Question: In a single sentence, describe what this figure presents.
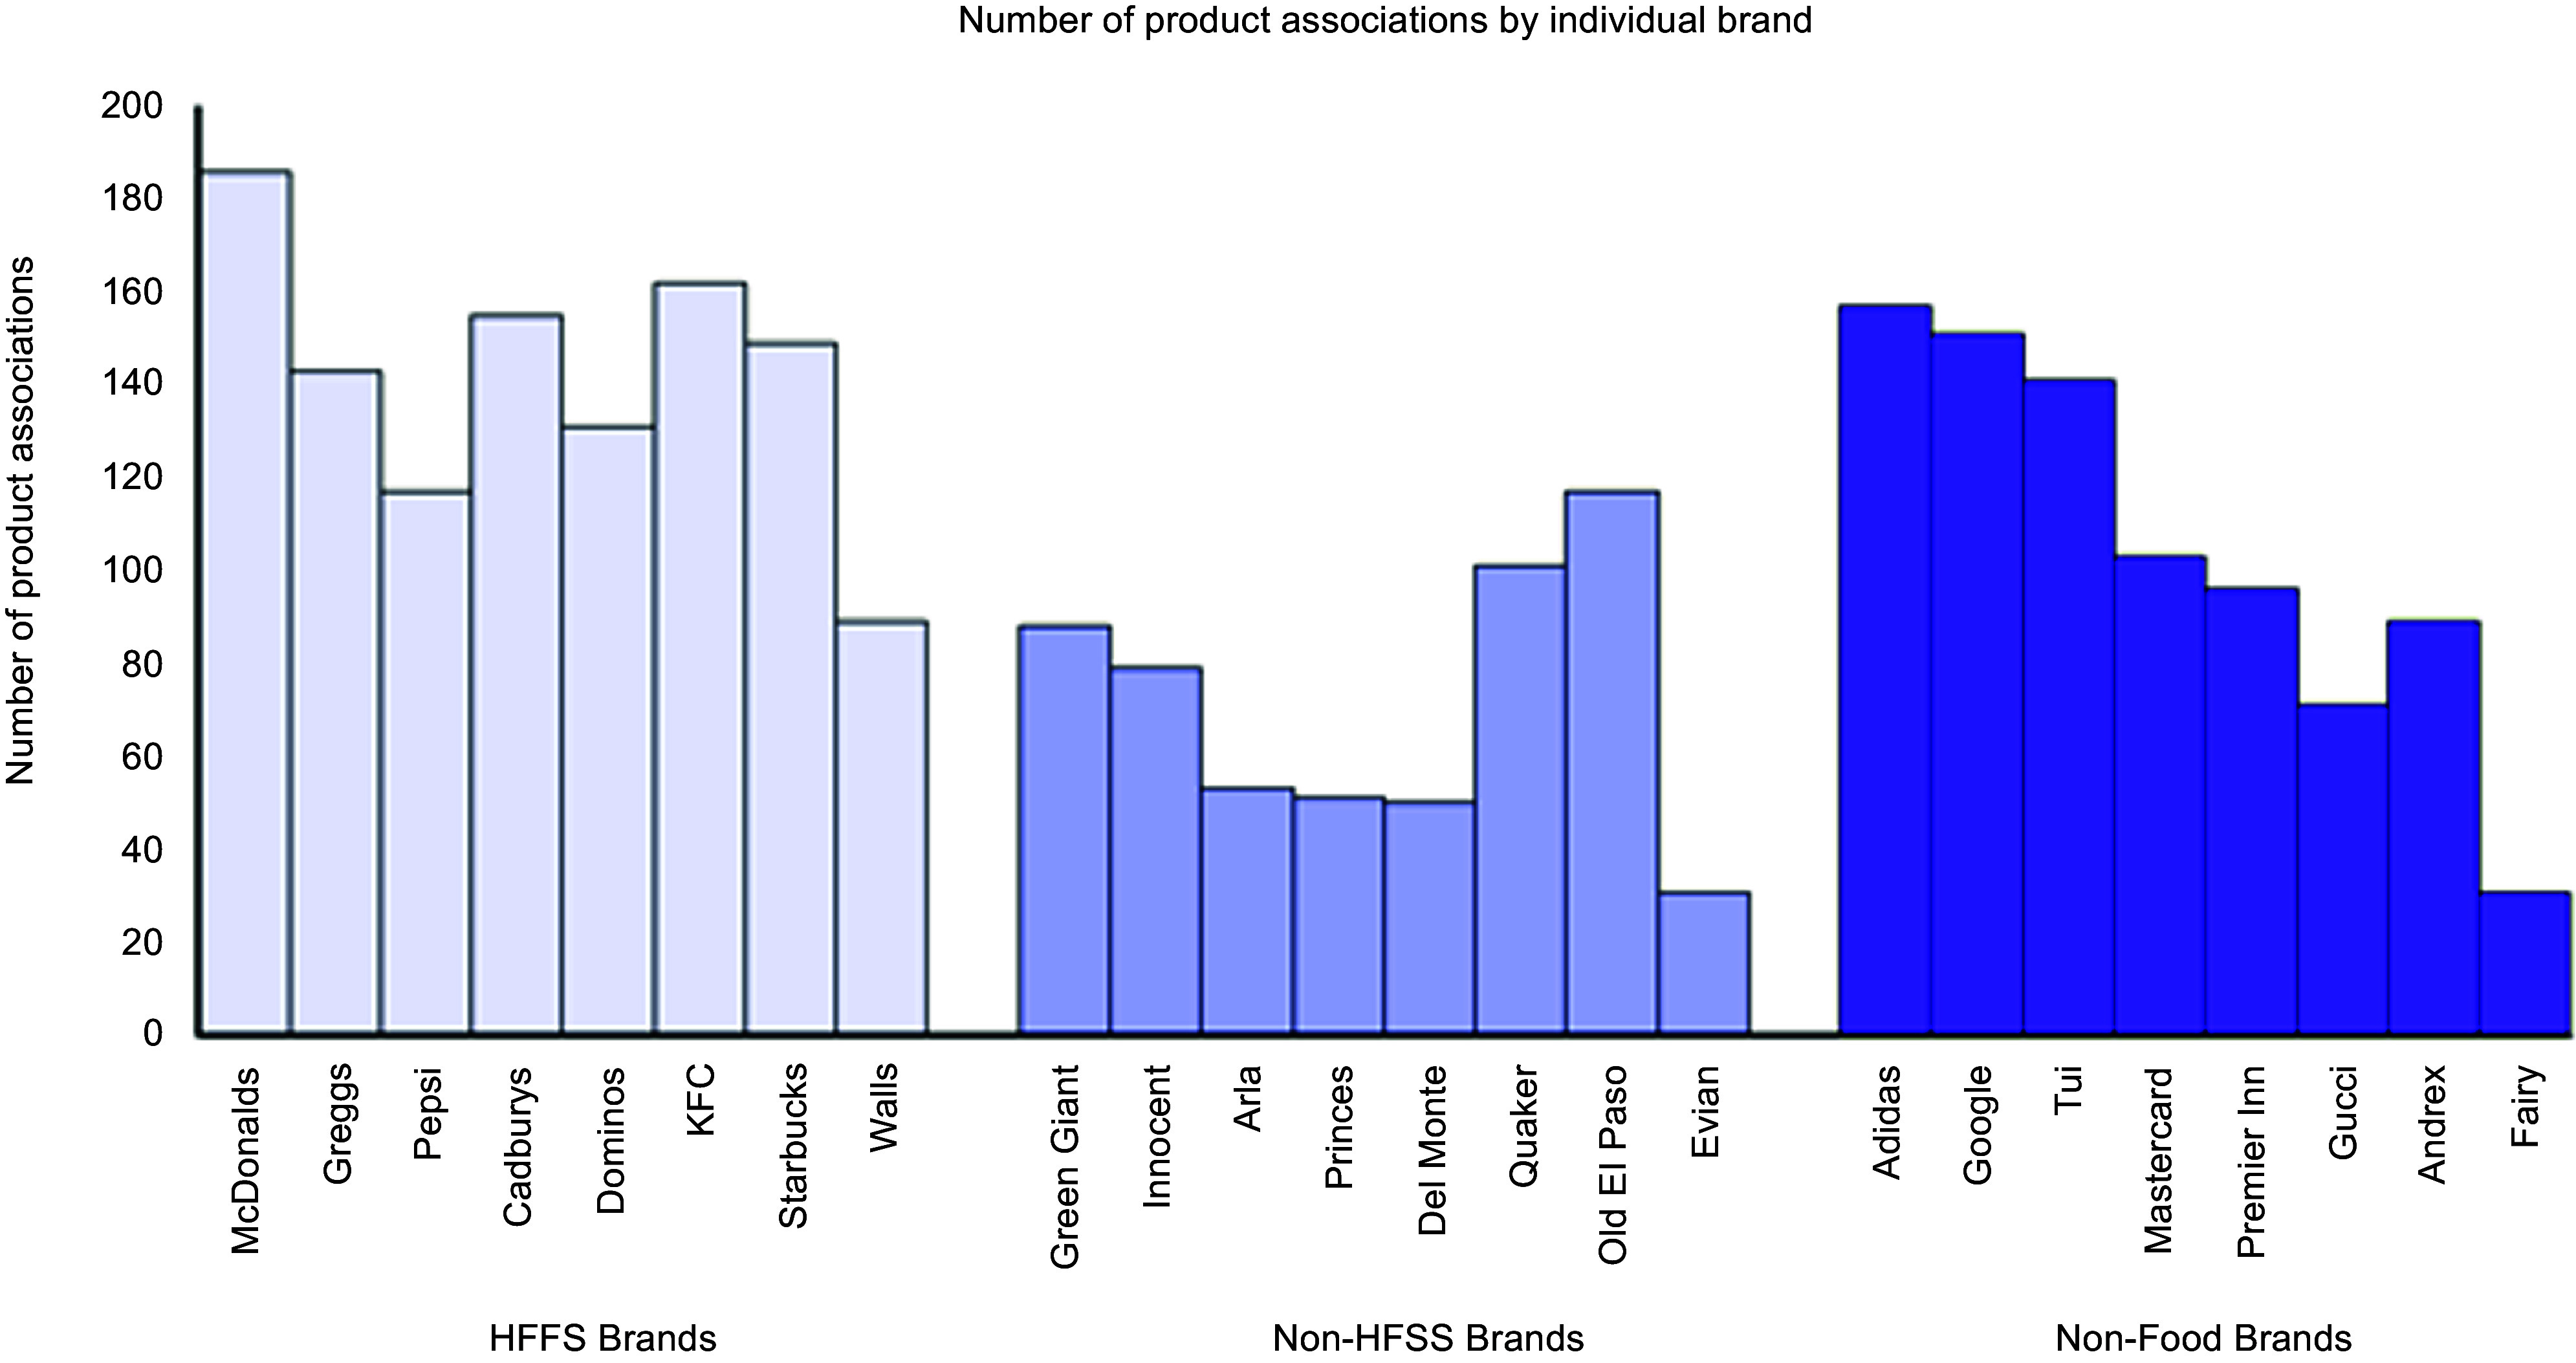
Answer: A bar chart showing the total number of product associations for each individual brand.